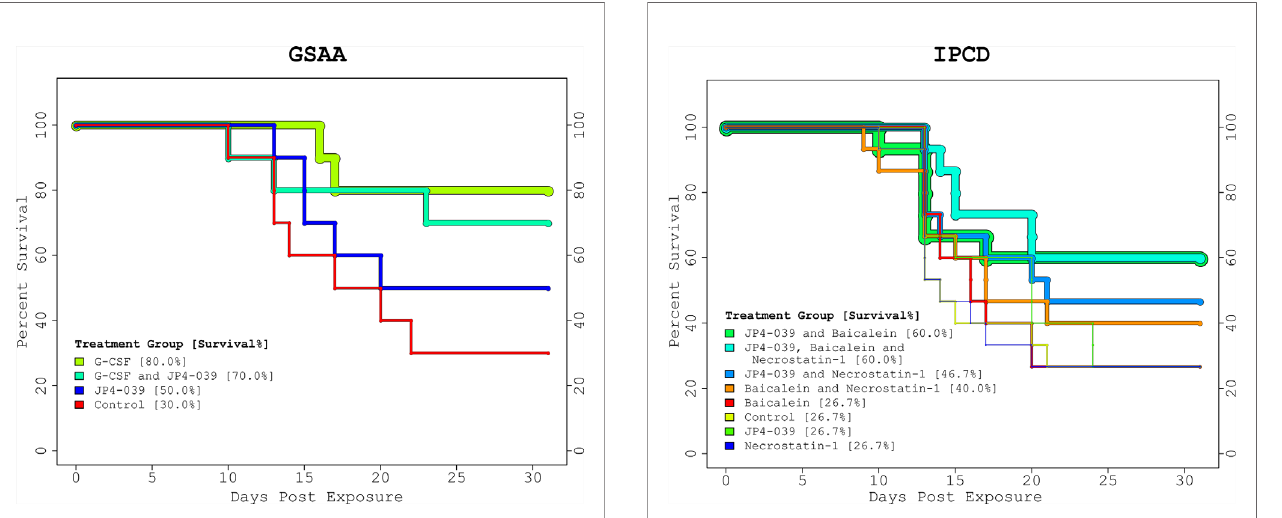
FIGURE 2 | IPCD Experiment Kaplan-Meier Plot. The KM plot for the 3 drug IPCD experiment illustrates the survival rates of the 8 treatment combinations. Day 0 and 1 are baseline and post-irradiation, respectively. The critical period between days 9 to 24, when any mice requiring euthanasia were sacri fi ced, match the time period in the GSAA experiment. The single drug treatments performed as well as the control with a 26.67% survival rate. The top performing combinations included both JP4-039 and baicalein. With and without necrostatin-1 (p-value = 0.0359, and p-value = 0.0995, respectively), these treatment groups were statistically signi fi cantly different from the control, with survival rates of 60% versus